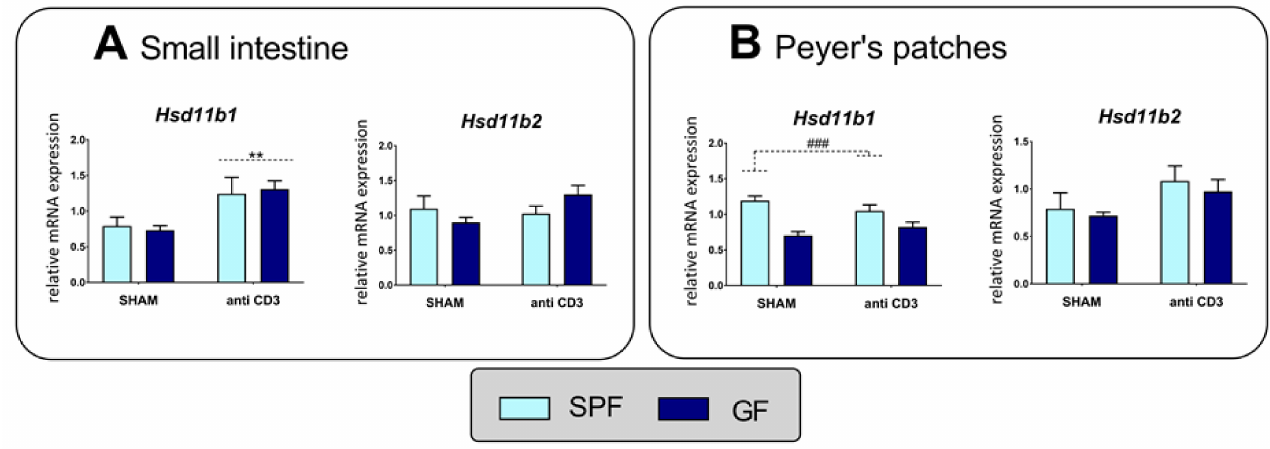
Figure 3. Effect of microbiota and acute immune stress on the expression of 11 β -hydroxysteroid dehydrogenase type 1 ( Hsd11b1 ) and 11 β -hydroxysteroid dehydrogenase type 2 ( Hsd11b2 ) in the small intestine ( A ) and Peyer’s patches ( B ). The data are expressed as means ± SEM. Main effect of microbiota has been marked by placing a dashed horizontal line with a hash sign ( ### p < 0.001) above the bars for the SPF groups, whereas a main effect of stress has been marked by placing a dashed horizontal line with an asterisk (** p < 0.01) above the bars for the stress-exposed